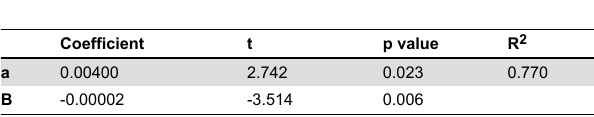
Table 2. Relationships between habitat features and lizard abundance in the Qom Province of Iran.